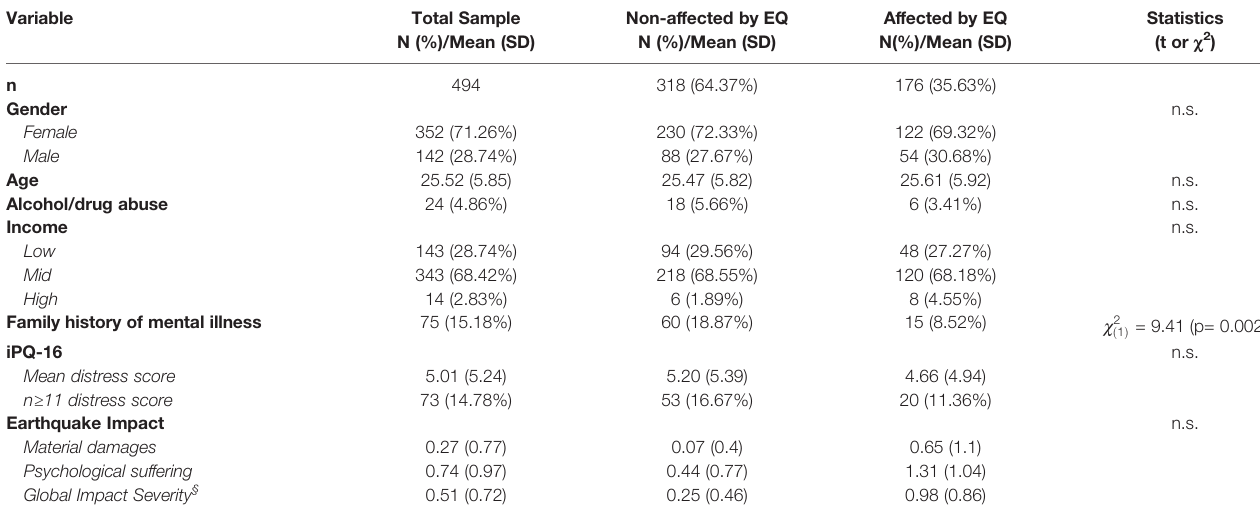
TABLE 1 | Characteristics of the